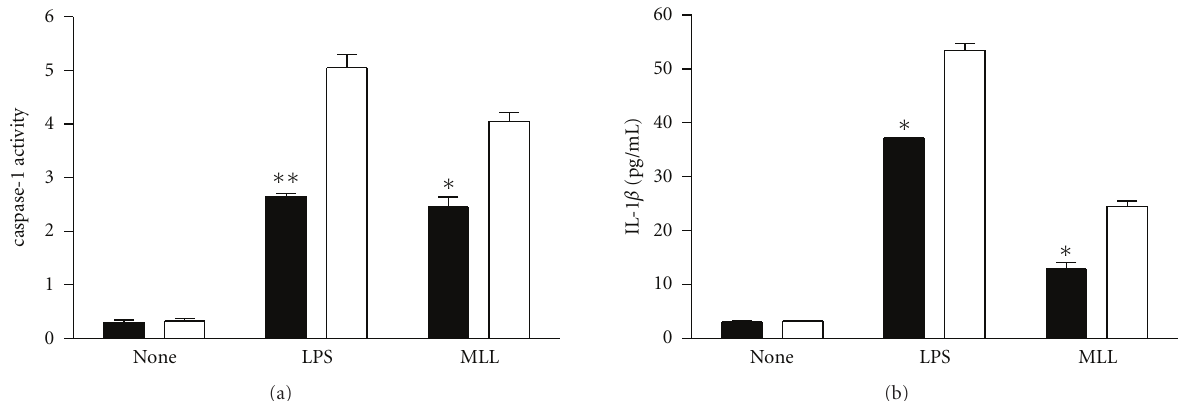
Figure 3: Caspase-1 activity and IL-1 β production in response to M. leprae lysate (MLL) in macrophages from A/J and C57BL/6 mice. Macrophages (10 6 ) from C57BL/6 and A/J mice were treated with LPS (100 ng/ml) and the cell lysates of M. leprae (1 μ g/ml) for 18 h, and supernatants and cell lysates were assayed for IL-1 β concentrations and for caspase-1 activity, respectively. Open bar and closed bar represent macrophages from C57BL/6 and A/J mice, respectively. Data are representative of at least three independent experiments, each performed in triplicate. ∗ P < . 05; ∗∗ P < .